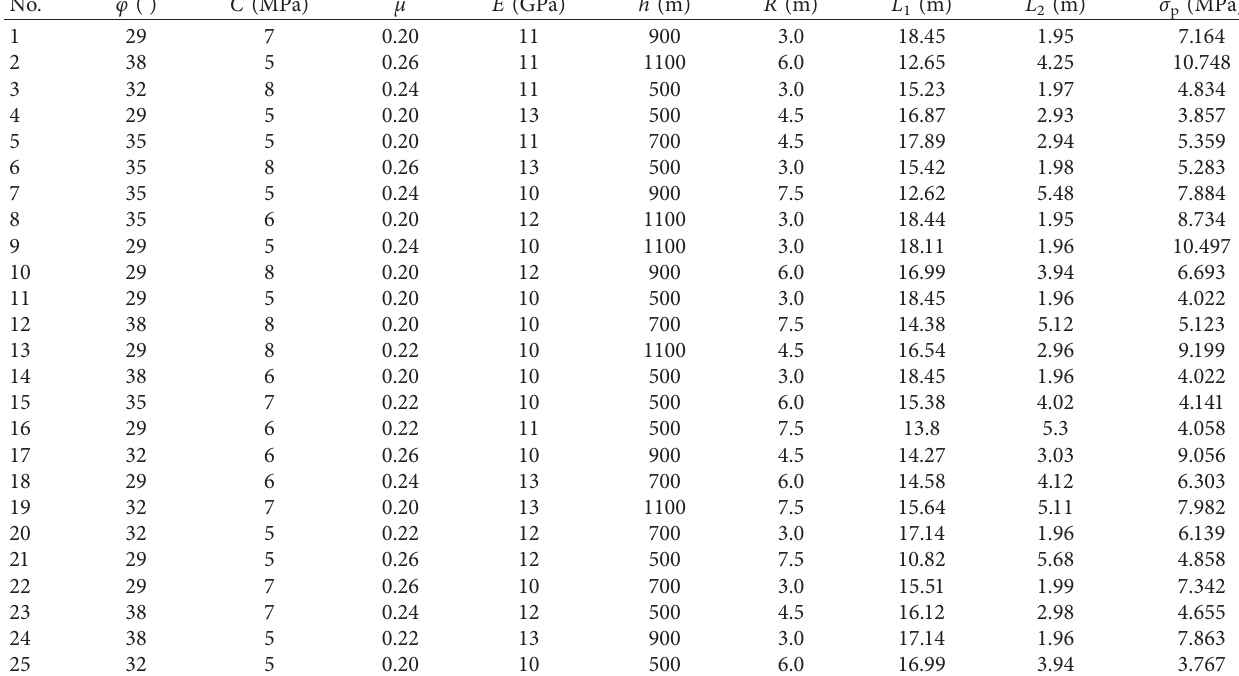
Table 1: Design and results of the orthogonal test.